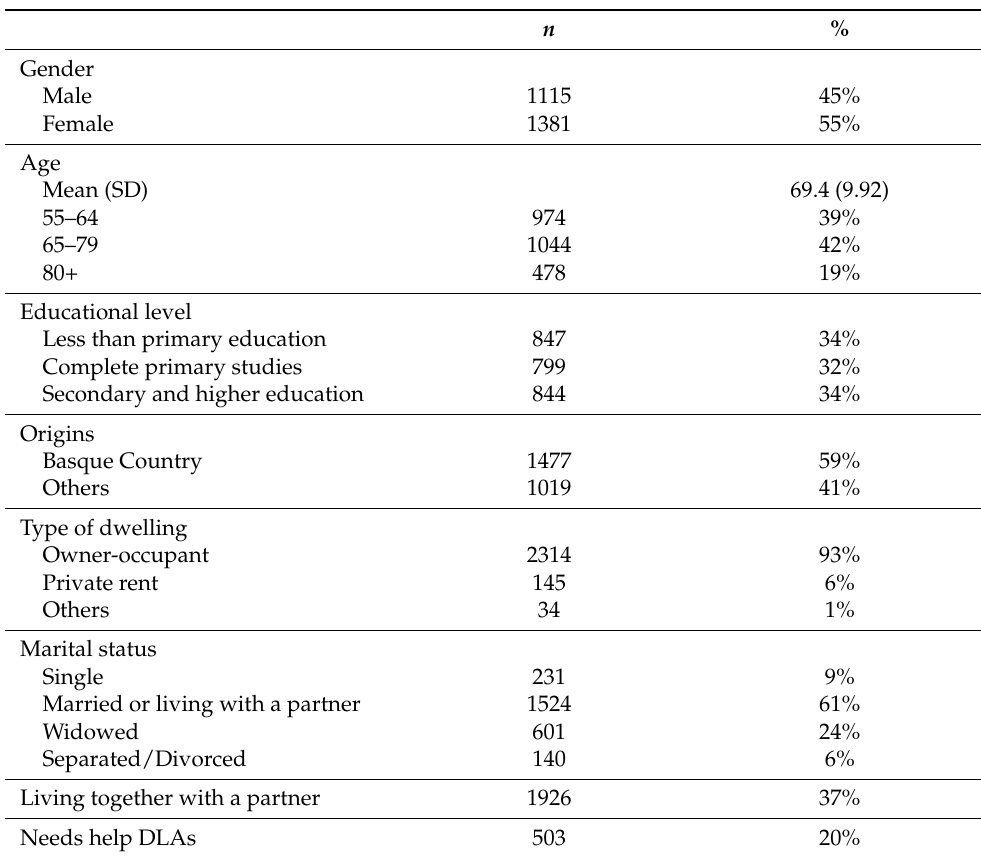
Table 1. Demographics of participants ( n =